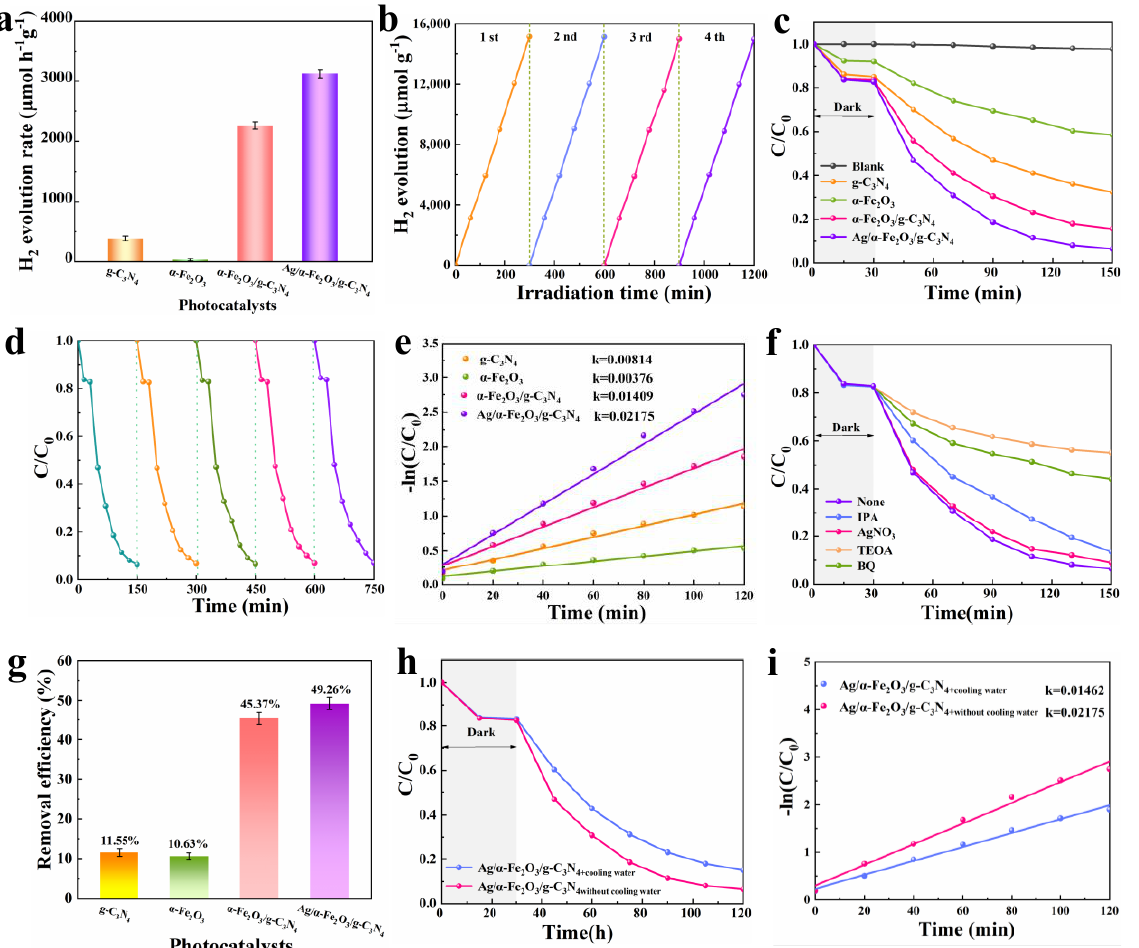
Figure 6. Hydrogen production rate ( a ), hydrogen production rate cycling performance ( b ), photocatalytic-Fenton degradation performance ( c ), degradation cycling performance ( d ), the first- order kinetic curves ( e ), free radical quenching experiments ( f ), contaminant mineralization perfor- mance ( g ), cyclic cooling experiments ( h ), cyclic cooling first-order kinetic curves ( i ) for g-C 3 N 4 , α -Fe α -Fe α -Fe 2 O 3 , 2 O 3 /g-C 3 N 4 and Ag/ 2 O 3 /g-C 3 N 4